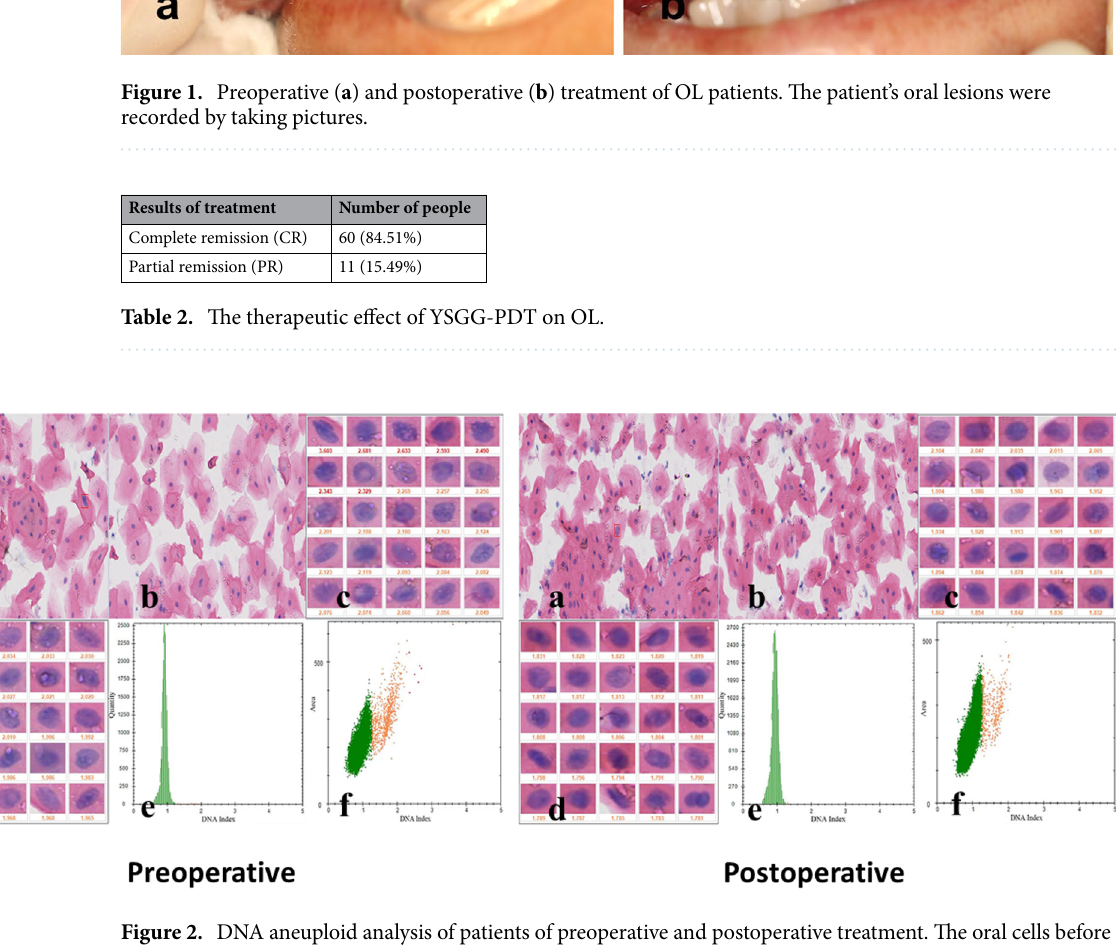
Figure 2. DNA aneuploid analysis of patients of preoperative and postoperative treatment. The oral cells before and after treatment of YSGG-PDT were analyzed by TCT, and cytological classification and diagnosis were performed. DNA ploidy was used to analyze the changes in the number of DNA ploidy in oral cells before and after YSGG-PDT treatment. ( a ) The staining quality of cell smear preparation (Staining Feulgen, lens 100×); ( b ) The morphology of normal cells (Staining Feulgen, lens 100×); ( c ) The morphology of abnormal oral cells (Staining Feulgen, lens 400×); ( d ) Other abnormal cells, including pathogenic microorganisms (fungi, trichomonas, parasites, etc.) (Staining Feulgen, lens 400×); ( e ) The histogram shows the distribution of cells of different volumes and abnormal cell peaks (double peaks, three peaks, multiple peaks, abnormal peaks, etc.); ( f ) The scatter diagram shows the number of cells of different DNA